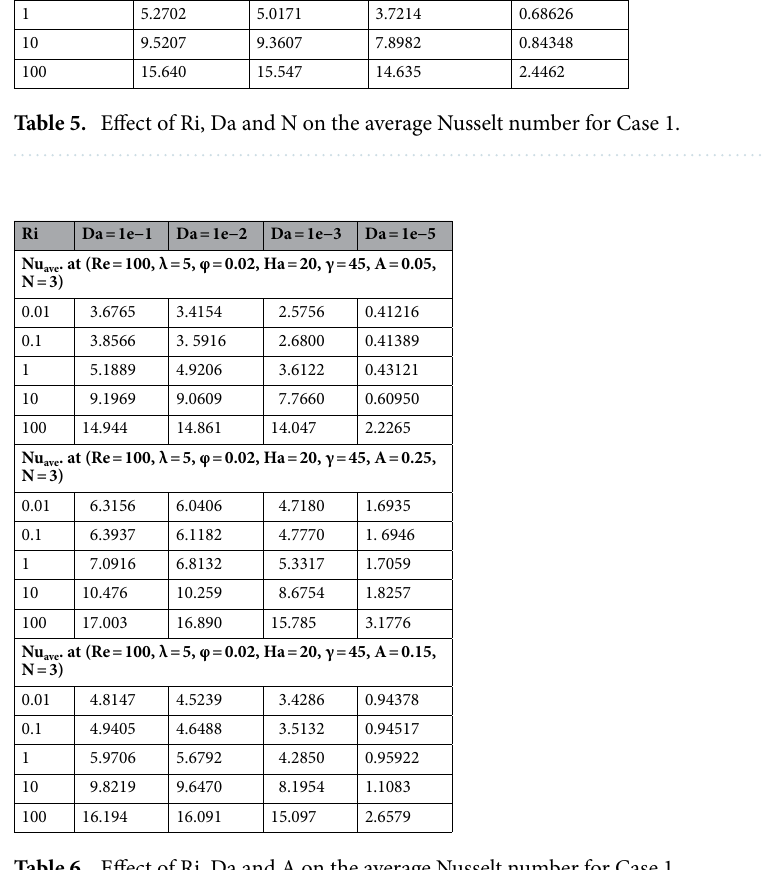
Table 6. Effect of Ri, Da and A on the average Nusselt number for Case